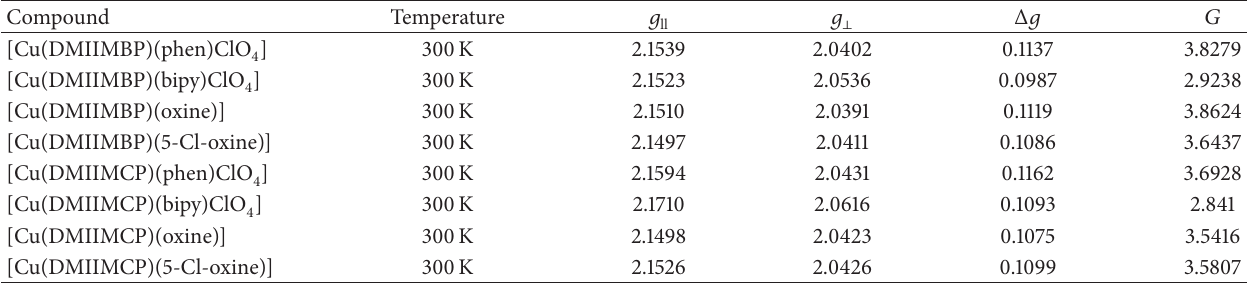
Table 4: ESR data of copper metal complexes 1–8